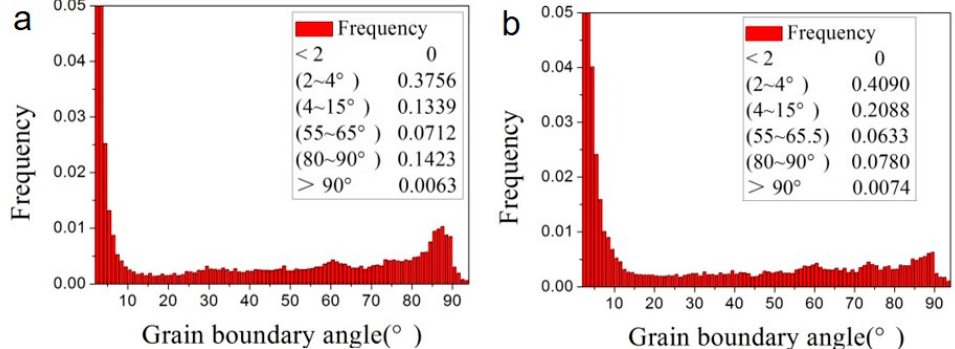
Figure 4. Inverse pole figure maps and local misorientation maps of various samples: ( a , b ) AE; ( c , d )